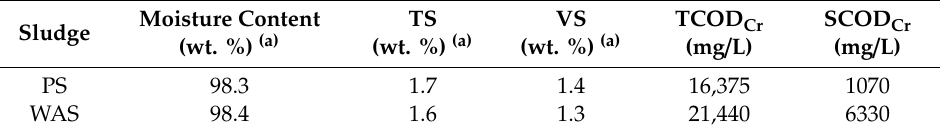
Table 1. Characteristics of PS and WAS as sludges.